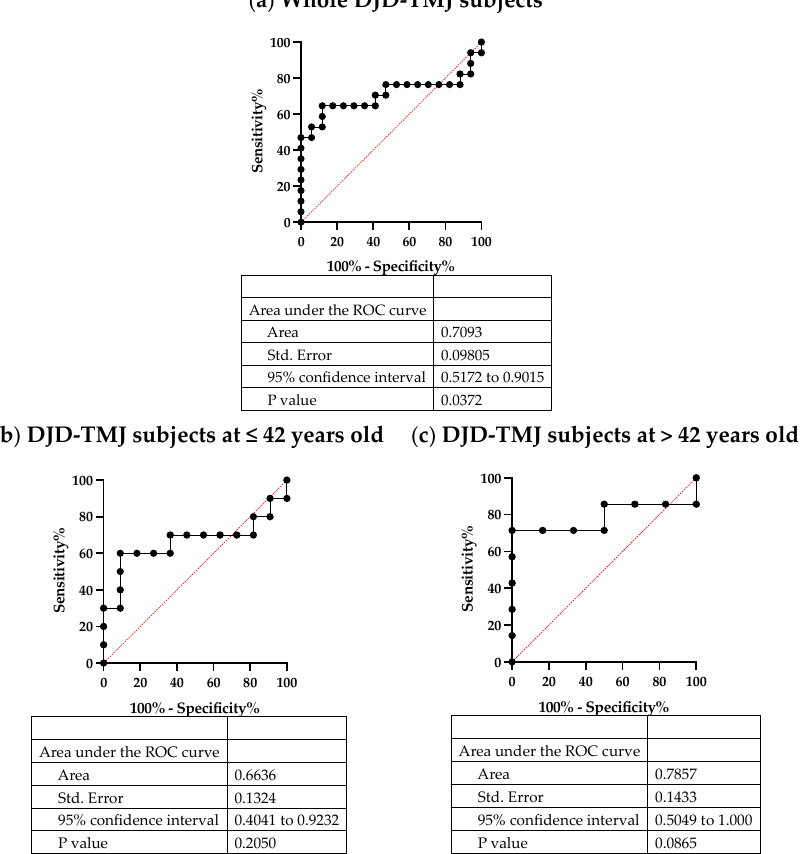
Figure 7. ROC curve analyses of CCL5. ROC curve analyses of CCL5 in ( a ) all DJD-TMJ patients (n = 17), ( b ) the group of all DJD-TMJ subjects ≤ 42 years old (n = 11), ( c ) the group of all DJD-TMJ subjects > 42 years old (n = 7) are shown.